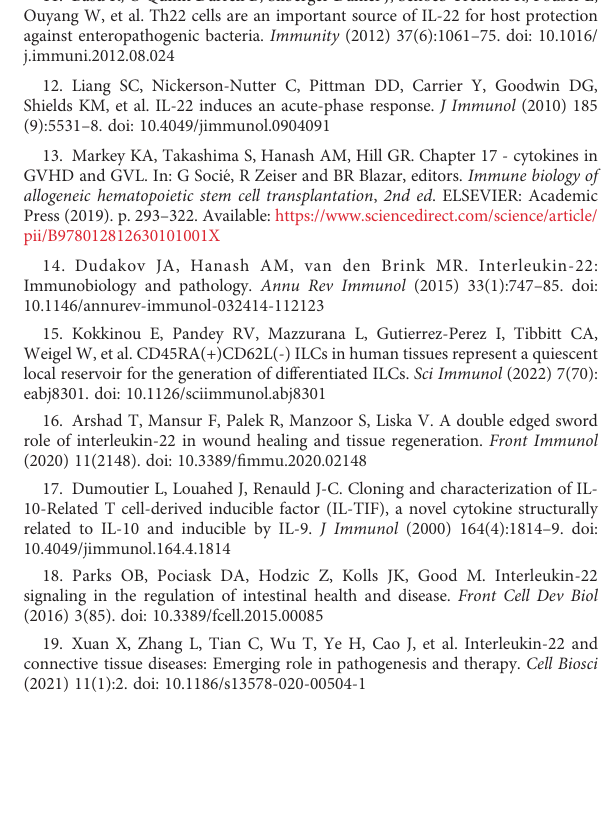
SUPPLEMENTARY FIGURE 4 The expression of claudin-3 in IL-22 -/- and WT mice. (A) IL22 -/- , n=6 and